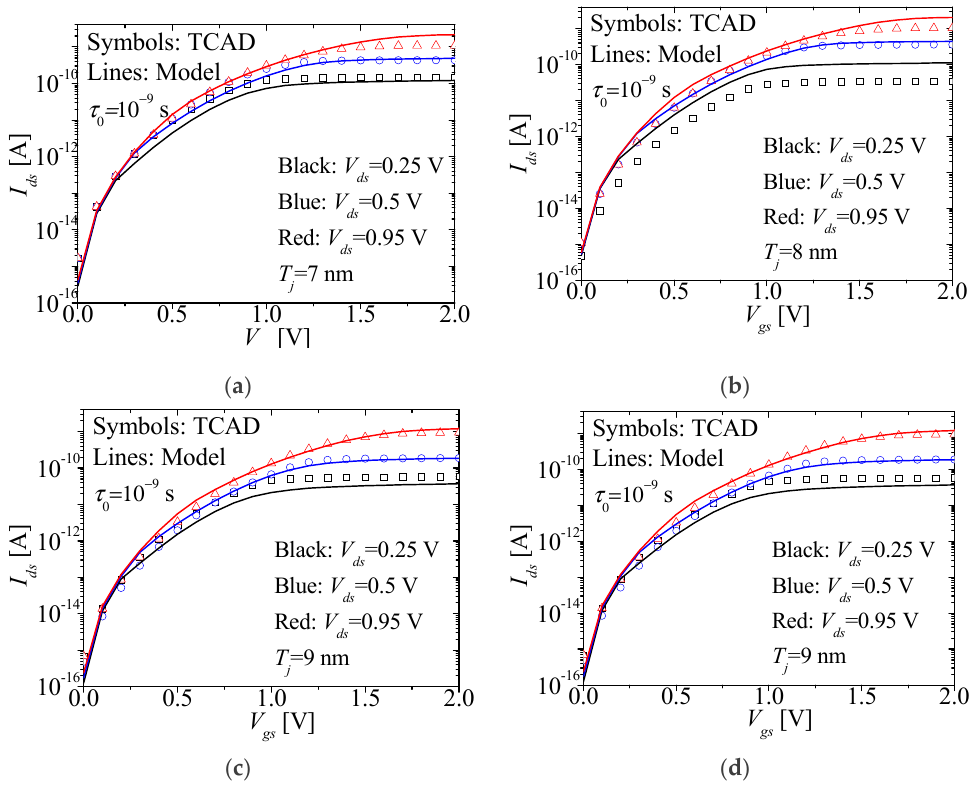
Figure 6. I ds_TAT from technology computer-aided design (TCAD) (symbols) compared with I ds_TAT calculated from (24) for T j = 7 nm ( a ), 8 nm ( b ), 9 nm ( c ) and 10 nm ( d ). Black, blue, and red represent V ds = 0.25, 0.5, and 0.95 V, respectively.